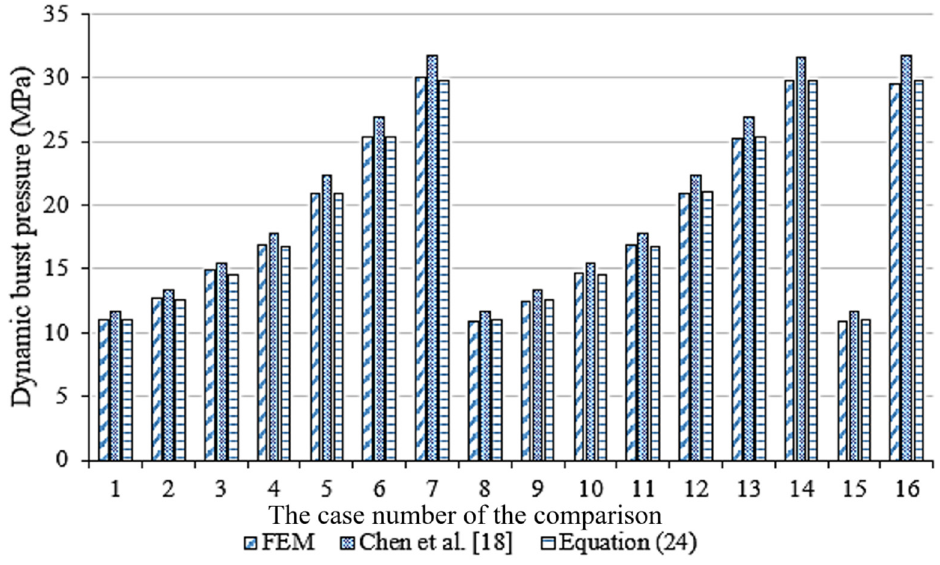
Figure 10. Comparisons between the FEM results and Equation (24), when t d = 39 ms.